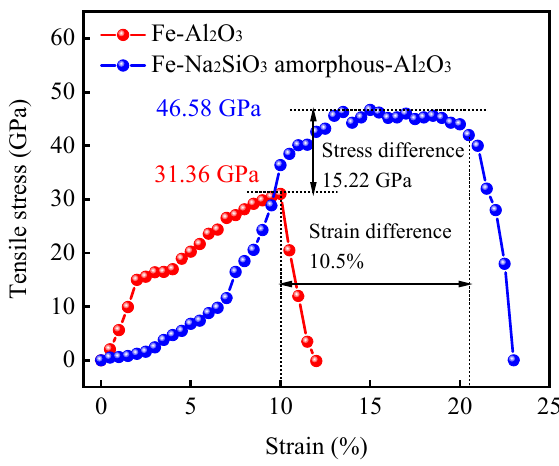
Figure 6. The tensile stress related to strain of the Fe-Al 2 O 3 and Fe-amorphous Na 2 SiO 3 -Al 2 O 3 inter-